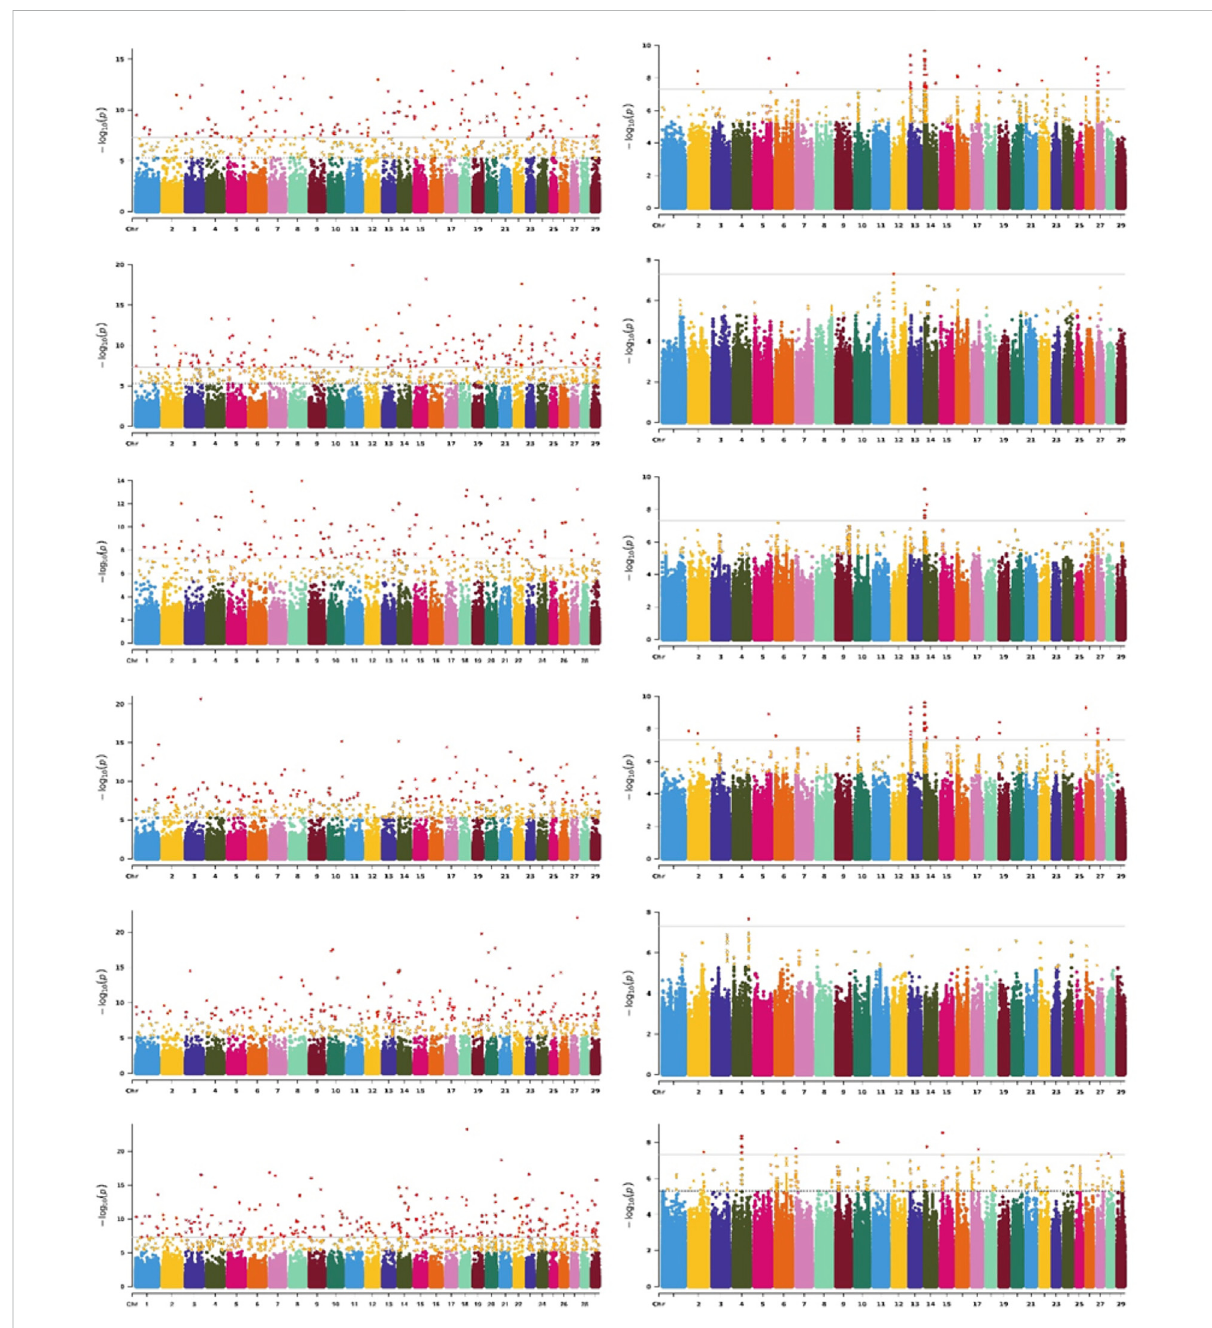
FIGURE 4 Signi fi cance [− log 10 ( Pvalue s )] of the association of WGS based on analyses using FarmCPU (left) and MLM (right) with the TD7 of six traits, MY, FP, FY, PP, PY, and SCS (top to down) across 29 autosomes. The grey solid line indicates the Bonferroni multiple test threshold at p = 5 × 10 − 8